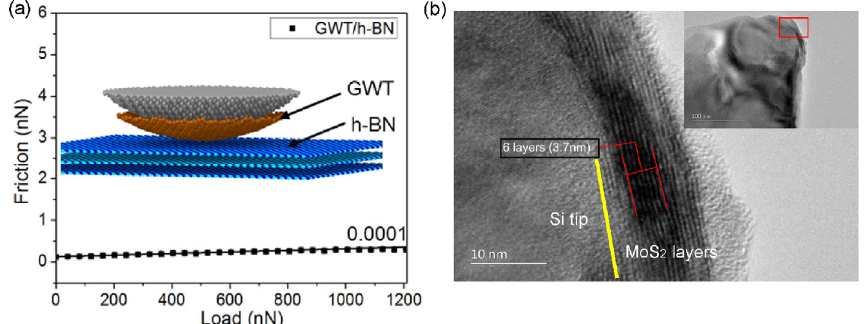
Fig. 3 (a) Friction between graphite flake-wrapped tip and h-BN substrate. The inset was the schematic view of the experimental tip and the substrate, (b) HRTEM images of the MoS 2 flake wrapped-tip. Reproduced with permission from Ref. [32]. © American Chemical Society,